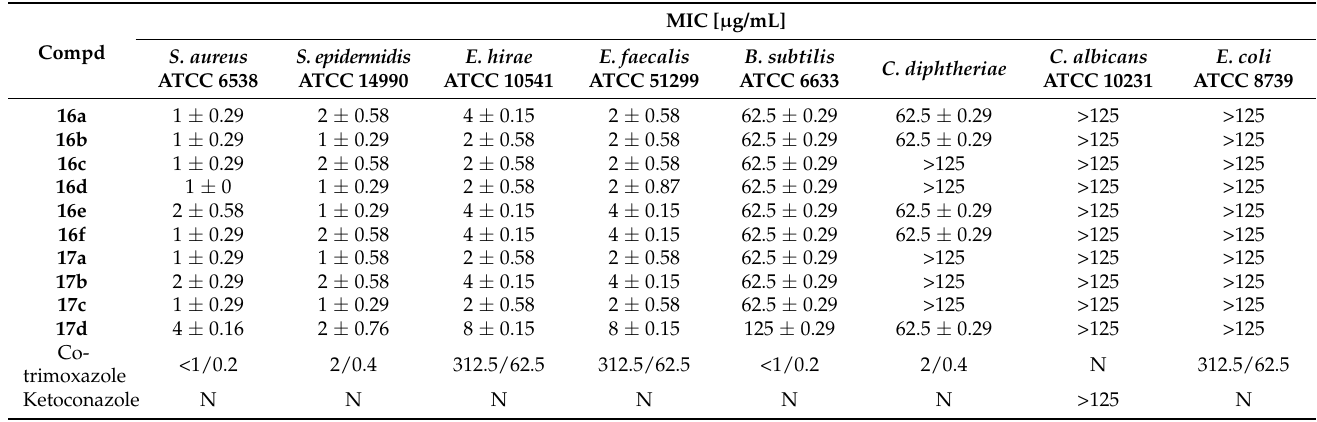
Table 1. Minimum inhibitory concentration (MIC) [ µ g/mL] of cinnamic acid derivatives on reference bacterial